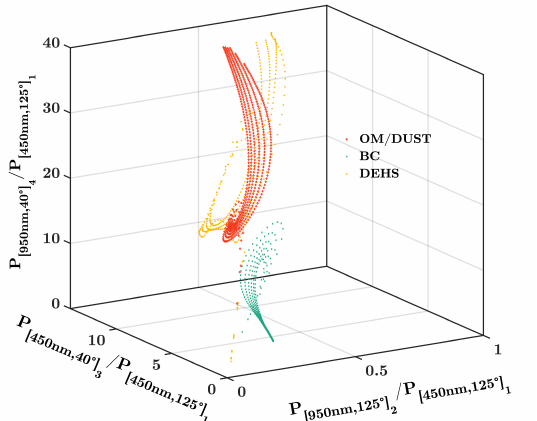
Figure 7. The T SMD of aerosol samples with different particle size distributions are mapped in the ratio vector space of scattering signals.